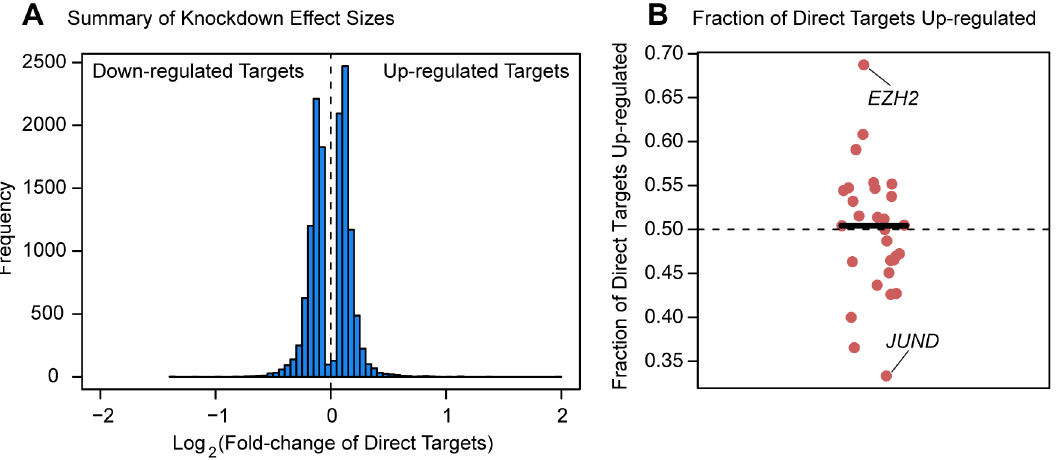
Figure 6. Magnitude and direction of differential expression after knockdown. (a) Density plot of all Log 2 (fold-changes) between the knockdown arrays and controls for genes that are differentially expressed at 5% FDR in one of the knockdown experiments as well as bound by the targeted transcription factor. (b) Plot of the fraction of differentially expressed putative direct targets that were up-regulated in each of the knockdown experiments.